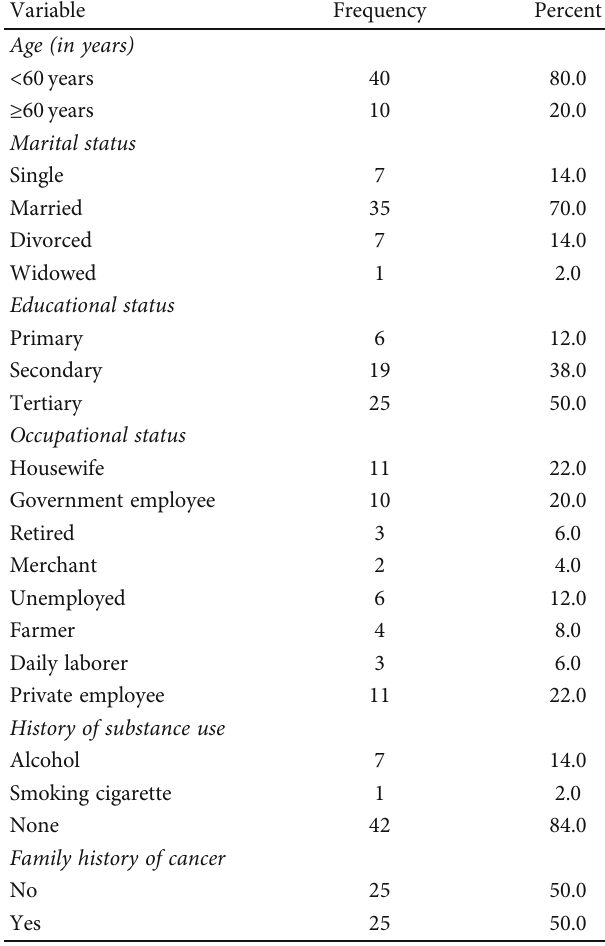
Table 1: Socio-demographic characteristics of HER2-positive breast cancer